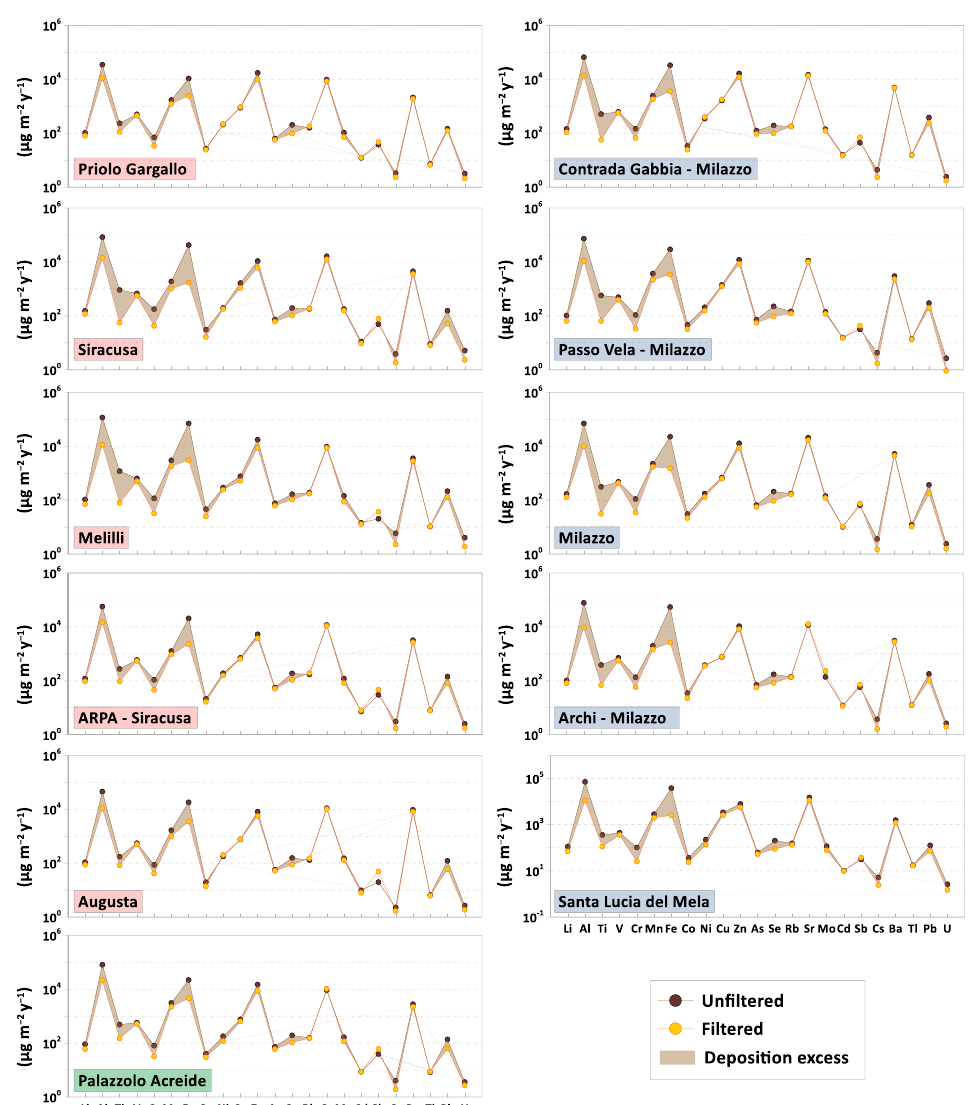
Figure 8. Annual atmospheric bulk depositions for trace elements (μg m −2 yr −1 ), in the filtered and the unfiltered aliquot for all the sampling sites.